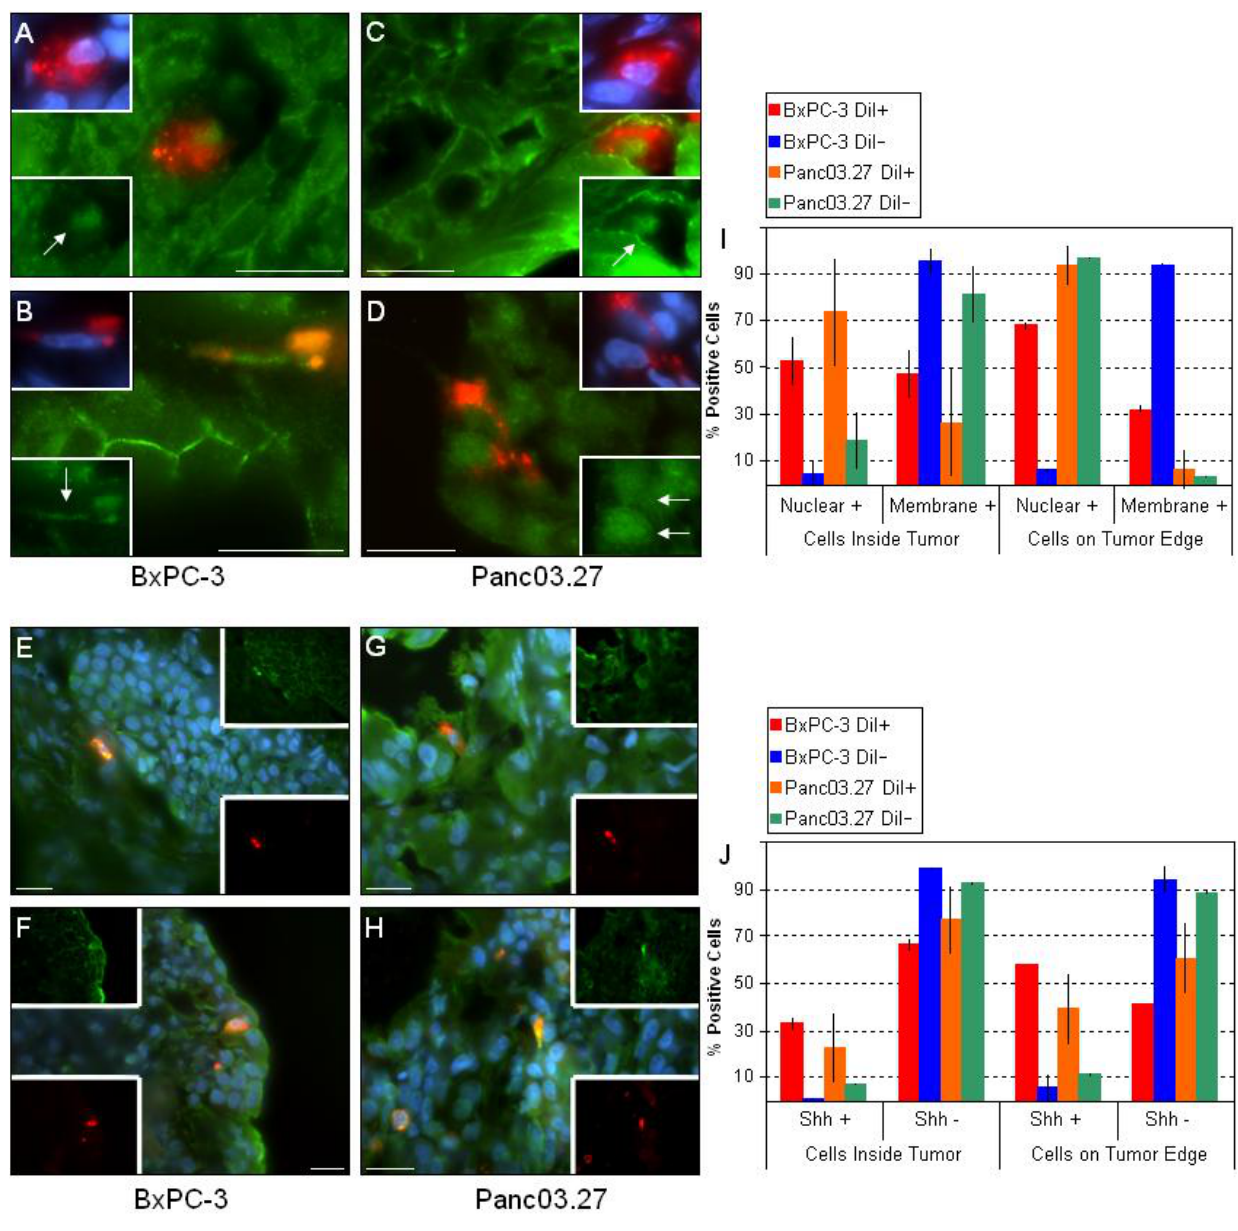
Figure 4. Key CSC Signaling Pathways. Sections from BxPC-3 and Panc03.27 tumors were stained against active beta-catenin ( A - D ) or Shh ( E - H ). DiI+/SCC tended to have nuclear + beta-catenin within the tumor ( A and C ) and increased nuclear beta-catenin on the tumor edge ( B and D ). ( I ) Graphical representation displaying nuclear vs. membrane staining of beta-catenin in DiI+/- cells inside the tumor or on the tumor egdes. Similarly, DiI+/SCC stained + for Shh as opposed to DiI-/FCC ( E - H ). DiI+/SCC increased expression of Shh when on the tumor edge ( F and H ) as compared to within the tumor ( E and G ). ( J ) Graph displaying percent Shh positive DiI+/- cells and location within the tumor. Bars represent 20